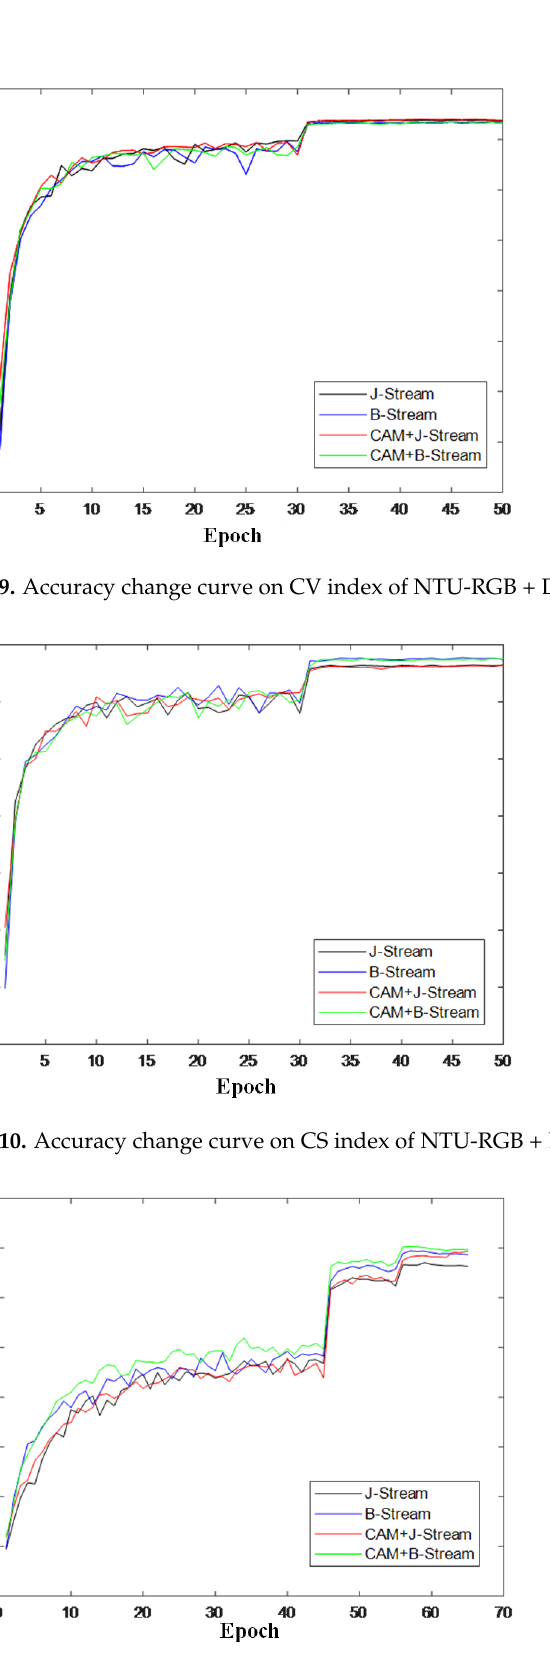
Figure 11. Accuracy change curve of